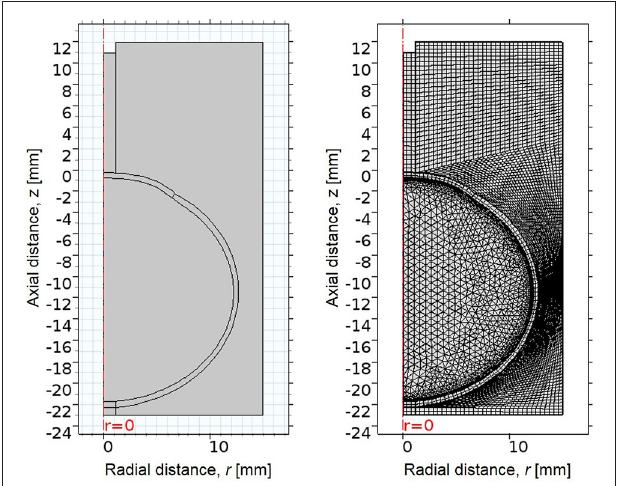
FIGURE 1 | (Left) 2D axisymmetric geometry of eye, consisting of cornea, sclera, and vitreous, surrounded by an air region. The x-axis indicates radial distance from the line of rotational symmetry, and the y-axis indicates axial distance, where the undeformed corneal apex is at 0mm. (Right) The mesh of the FE model, consisting of quadrilateral and free triangular elements.